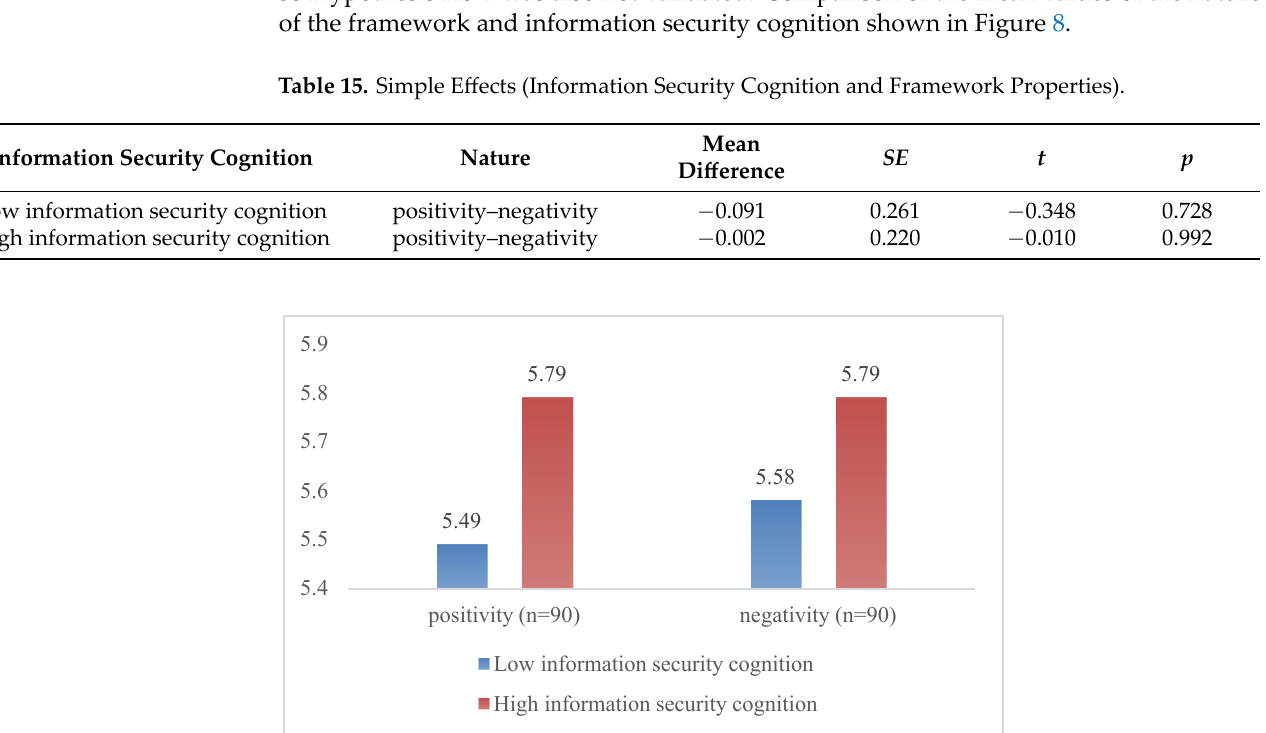
Figure 8. Comparison of the Mean Values of the Nature of the Framework and Information Security Cognition.